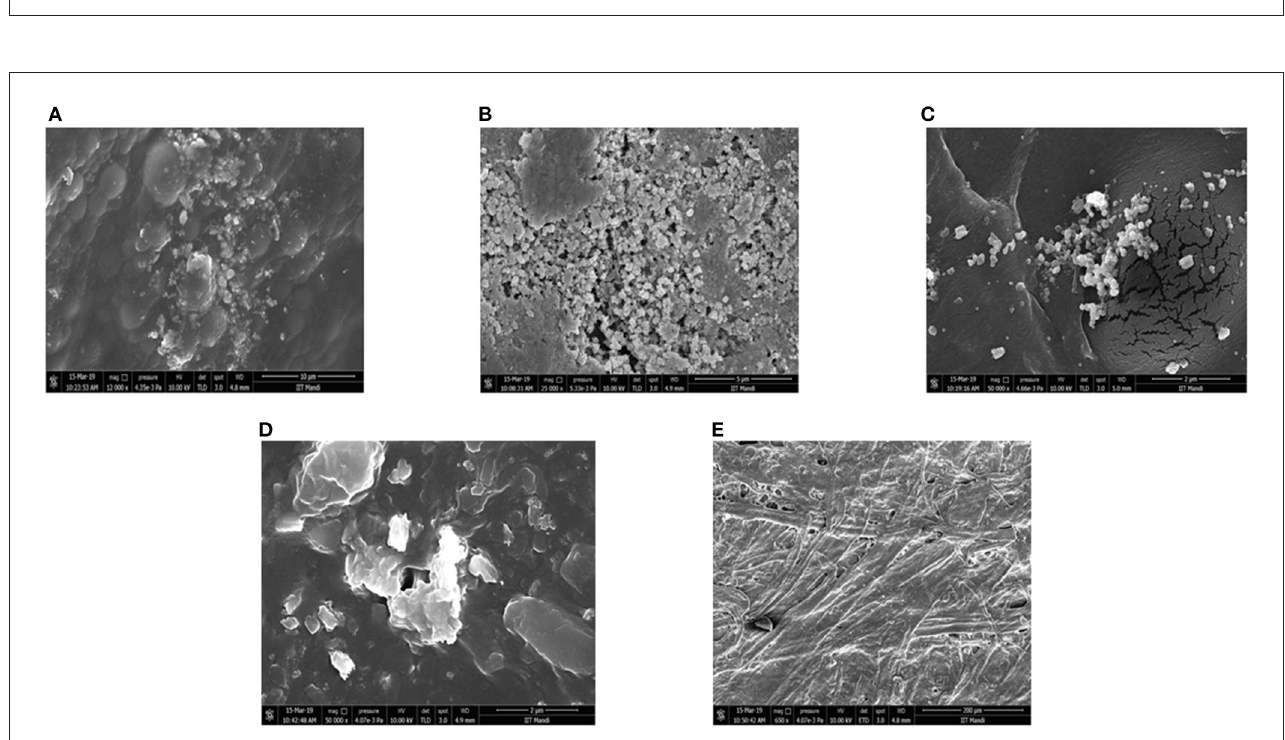
FIGURE4 Determination of morphology and structure of biosynthesized AgNP s using (A) SEM and (B) Tem techniques. Micrograph represents bacteriocin synthesized AgNP